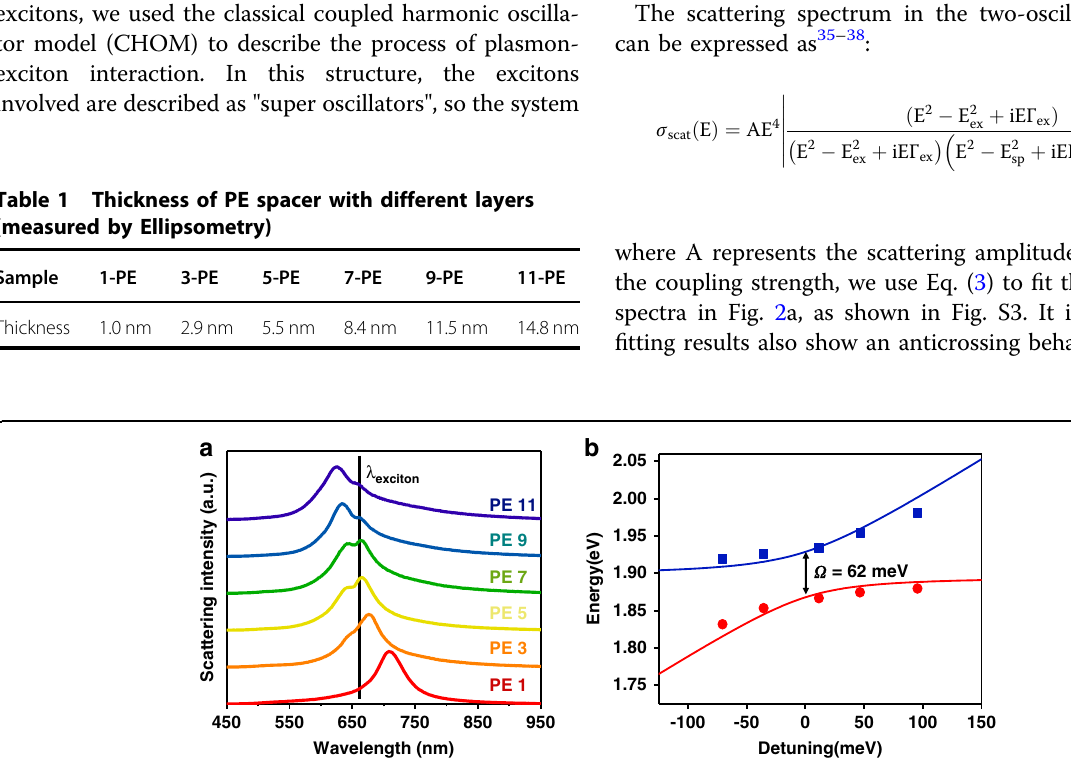
resonance of different nanocavities with various thick- nesses of PE layers, as shown in Fig. 2a. With the increase of PE layers thickness, the plasmon resonance frequencies gradually blue-shifts across the A exciton peak at 656 nm in Fig. S1. Meanwhile, the normalized dark- fi eld scatter- ing spectrums show peaks splitting with a characteristic dip at the wavelength of the A excitons (black line), which indicates the coherent coupling with plasmon-exciton interaction. When the materials of the Spacer layer are replaced by the air, there is no Rabi splitting in the scat- tering spectrums compared with the current Spacer (Fig. S12).